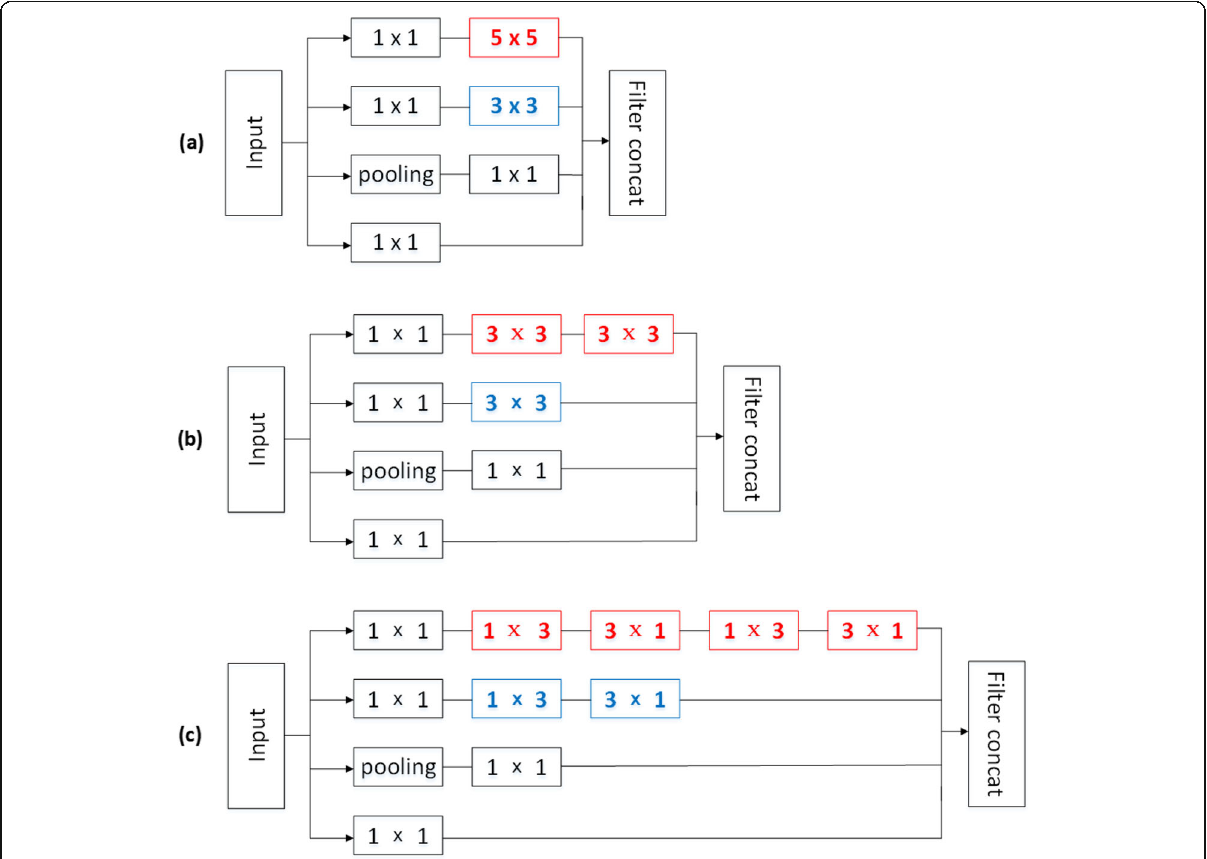
Fig. 3 The structure of the Inception module. a A four-branch convolution structure. b Obtained by replacing 5 × 5 convolution in a with 3 × 3 convolution in two cascades. c Replaced by 3 × 3 convolution in b with 1 × 3 convolution and 3 × 1 convolution